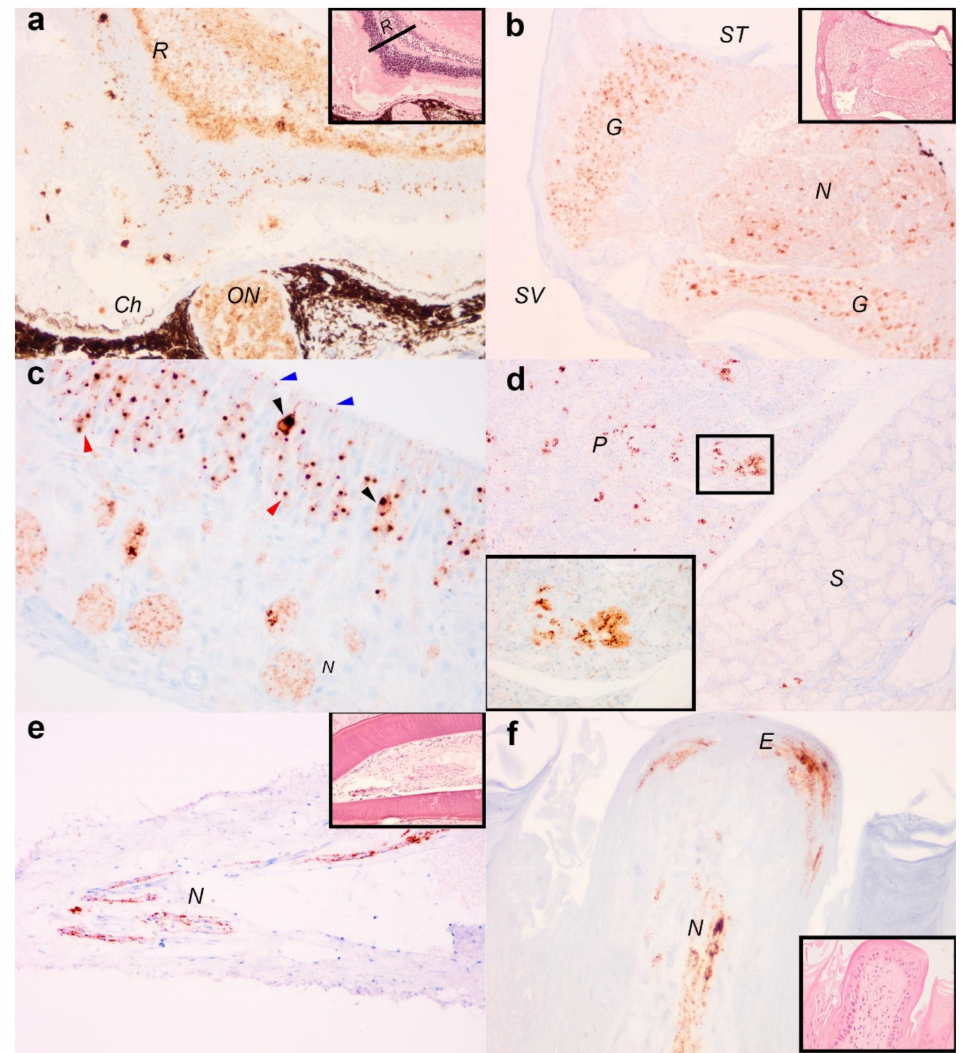
Figure 3. Distribution of EBLV-1 antigens in serotine bats ( E. serotinus ). ( a ) Eye, viral antigens are present in the retina (R) and optic nerve (ON) (images taken at 400 × ). Ch (choroid plexus). ( b ) Cochlear, viral antigens are present in the spiral ganglion (G) and nerve fibres (N) (images taken at 100 × , Scala vestibuli (SV), scala tympani (ST)). ( c ) Olfactory mucosa, viral antigens present in olfactory receptor cells (black arrow heads), basal cells (red arrow heads), cilia (blue arrow heads) and nerve bundles (N) (image taken at 400 × ). ( d ) Salivary glands, viral antigens are present in the acini (inset, magnified image taken at 400 × ), with more antigens in parotid gland (P) than the sublingual gland (S) (image taken at 100 × ). ( e ) Tooth, viral antigens present in nerve fibres within the tooth pulp (images taken at 200 × . ( f ) Fungiform papilla of the tongue, viral antigens present in stratified epithelial cells (E) and nerve fibres (N) (images taken at 400 × ). A selection of H&E stained sections (panels a , b , e , f ) were included as insets for the purpose of anatomical